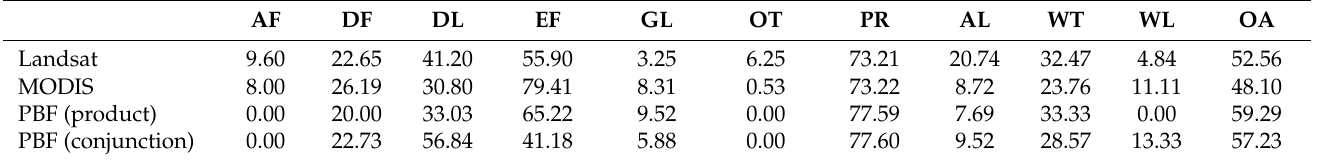
Figure 18. Fusion results from using the product combination rule in PBF. Table 8. Comparison of the class-wise and overall classification accuracy (%) for each dataset, including the PBF methods with product combination and conjunctive combination